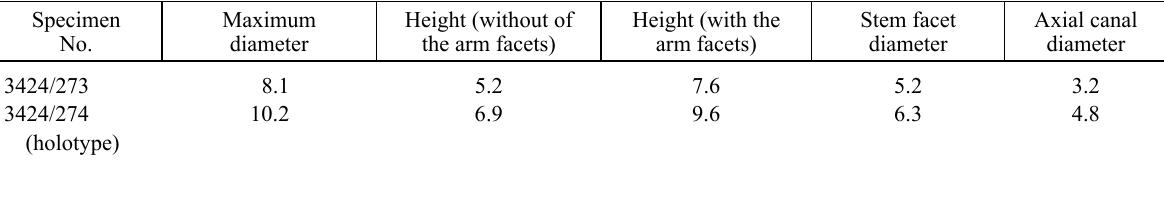
Fig. 2. Elgaecrinus uralicus sp. nov.: A – H , holotype PIN3424/274; A–F, lateral view (A, interray AB; B, interray BC; C, interray CD; D, ray D; E, interray DE; F, interray EA), G, top view, H, bottom view; I – O , paratype PIN3424/273; I–M, lateral view (I, interray AB; J, interray BC; K, interray CD; L, interray DE; M, interray EA), N, top view, O, bottom